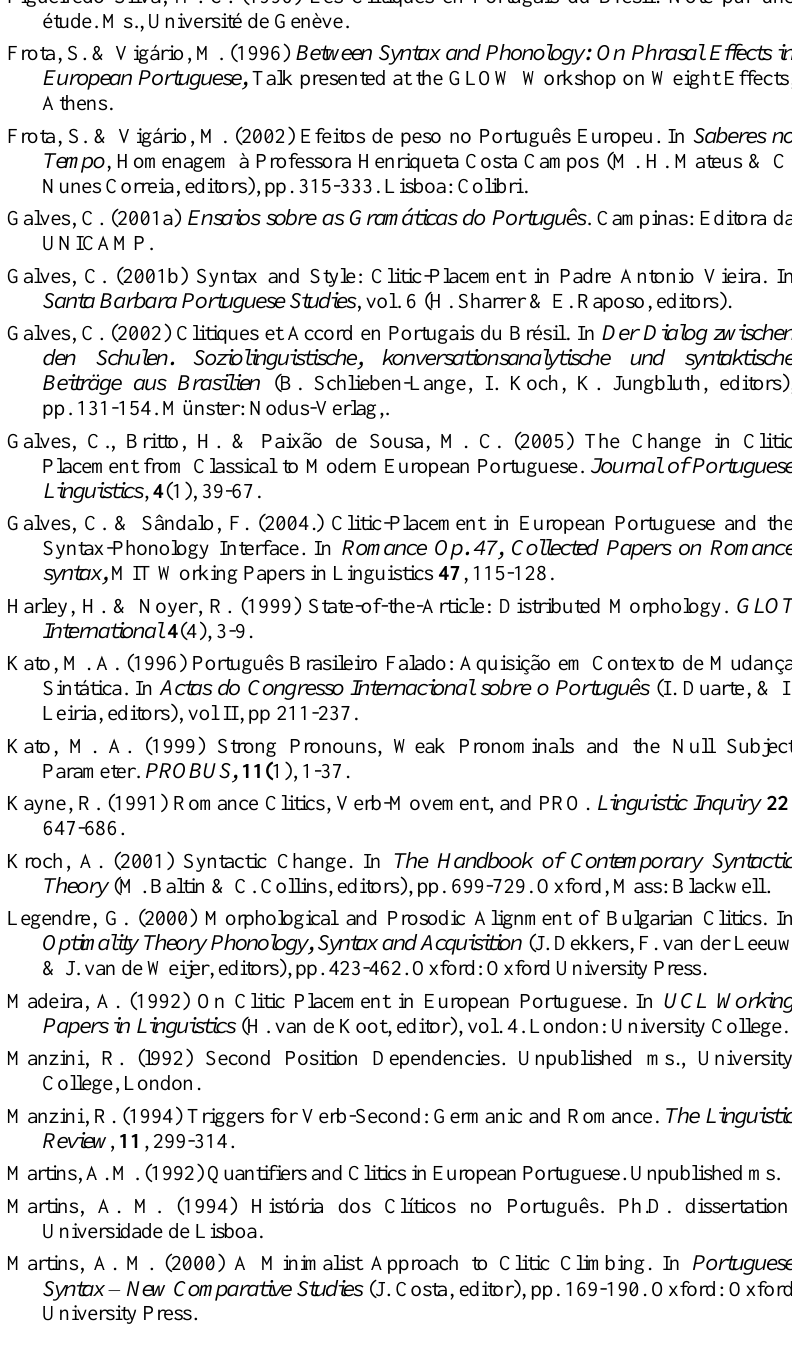
Figueiredo Silva, M. C. (1990) Les Clitiques en Portugais du Brésil. Note pur une étude. Ms., Université de